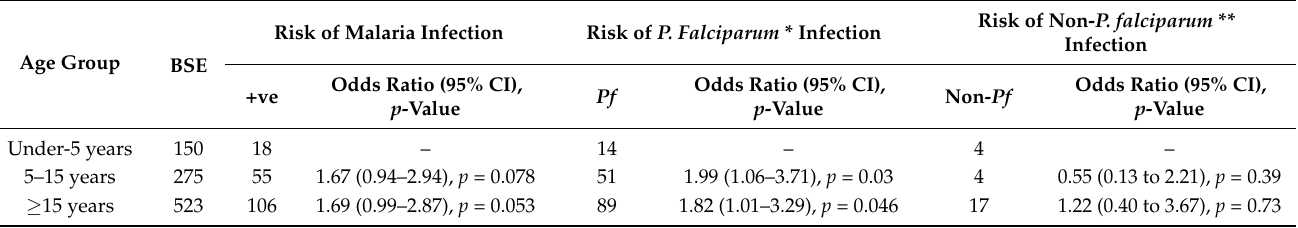
Table 2. Odds ratio of infection of parasite species among different age